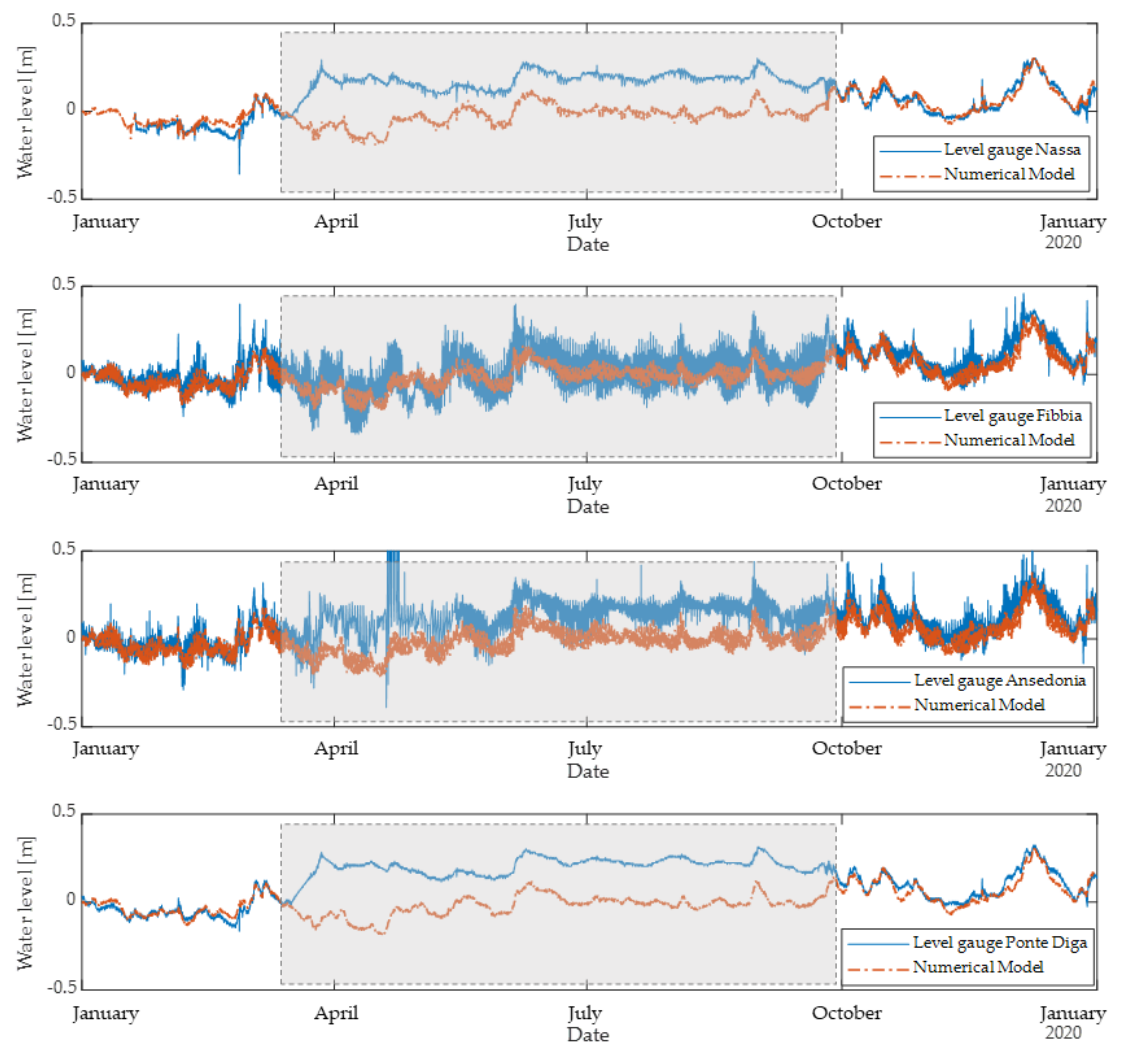
Figure 4. Comparison of time series of hourly water level measured at the different monitoring station and simulated by the numerical model. Gray rectangles denote periods in which the pumping systems (not simulated in the numerical model) were active at the lagoon inlets. From the top to the bottom, stations of Nassa, Fibbia, Ansedonia, and Ponte Diga.